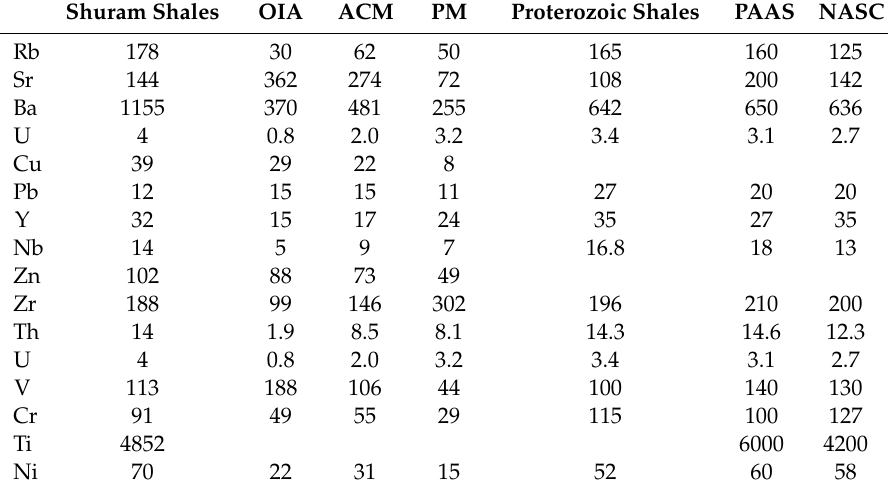
Table 1. Average trace element concentration of the Shuram Formation shales associated with di ff erent tectonic